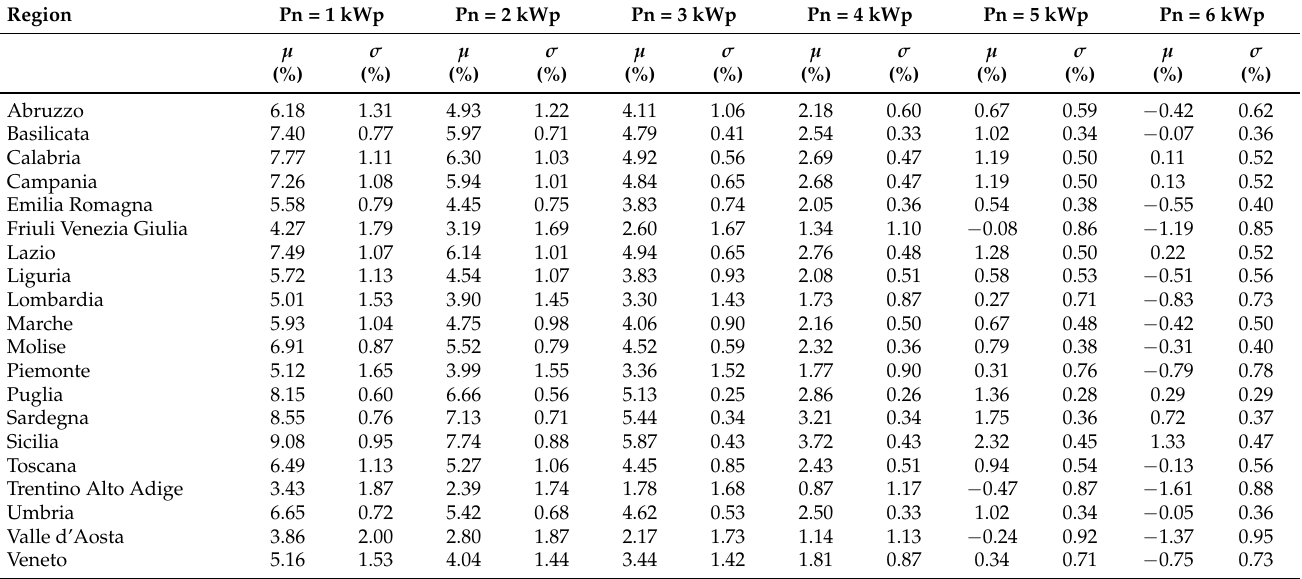
Table 17. IRR for E L = 4000 kWh without battery.